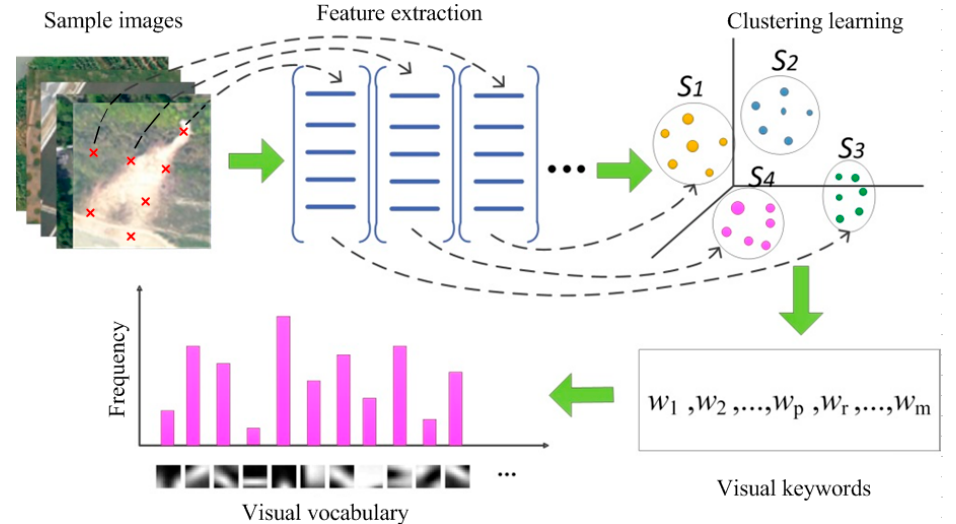
Figure 4. The flow chart of Bag of Visual Word (BOVW) feature extraction.